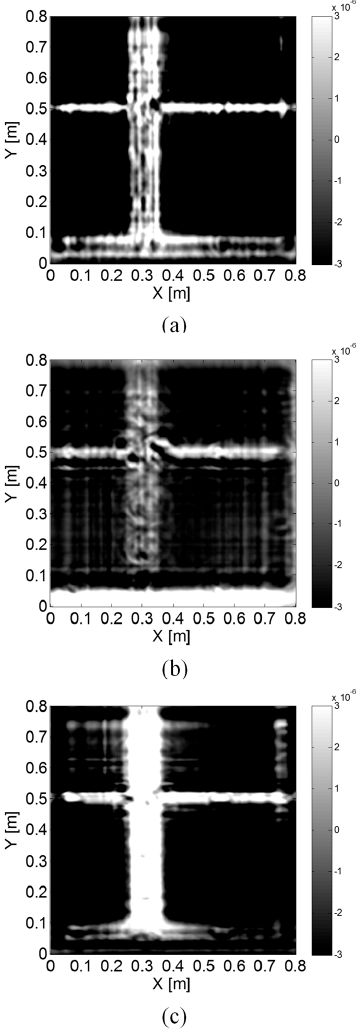
Figure 7. Reconstructed SAR image of the 2D survey on the Type I wall specimen (Figure 1a) in ( a ) HH; ( b ) HV; and ( c ) VV polarization channel.